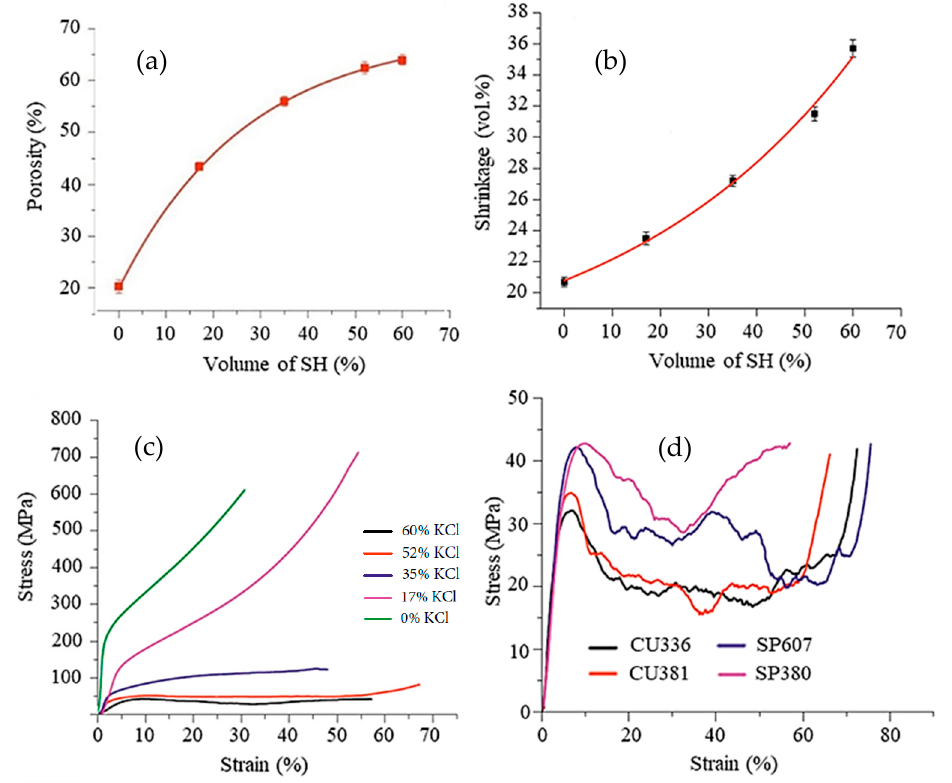
Figure 6. Properties of foams produced with commercially pure Ti powder (D 50 = 75 µ m) with a spherical shape, and spherical potassium chloride (D 50 = 366 µ m) as a space holder: ( a ) the relationship between the amount of space holder added and porosity in the sintered samples; ( b ) the correlation between the amount of space holder and volume shrinkage; ( c ) mechanical strength of samples with different amounts of porosity under compression; and ( d ) mechanical strength of foams under compression testing at a strain rate of 0.001 s − 1 produced using cubic KCl with a mean particle size of 336 µ m (CU336), cubic KCl with a mean particle size of 381 µ m (CU381), spherical KCl with a mean particle size of 607 µ m (SP607), and spherical KCl with a mean particle size of 380 µ m (SP380). The samples were sintered at 1320 °C for 2 h. Adapted from Ref. [30]. Open Access Copy- right.